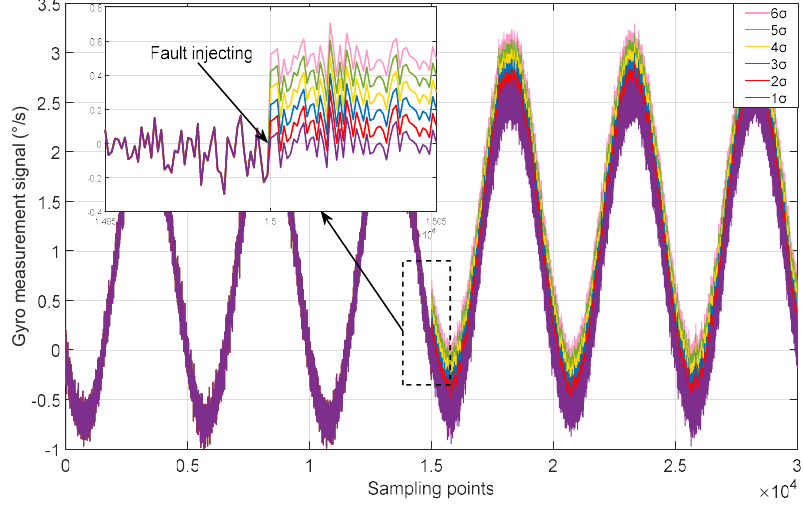
Figure 3. The gyro measurement signals with various constant drift faults.